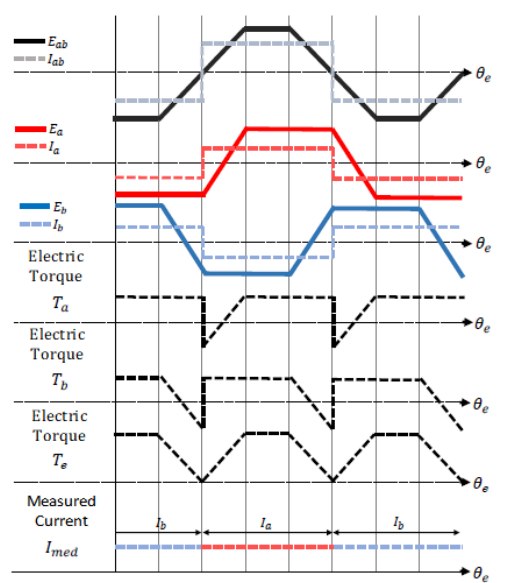
Figure 4. Waveforms of induced voltages, currents, torque and current observed by the controller of a BLDC motor with faut in phase c in 180° Six-Step operation mode. Table 2. Motor Parameters.